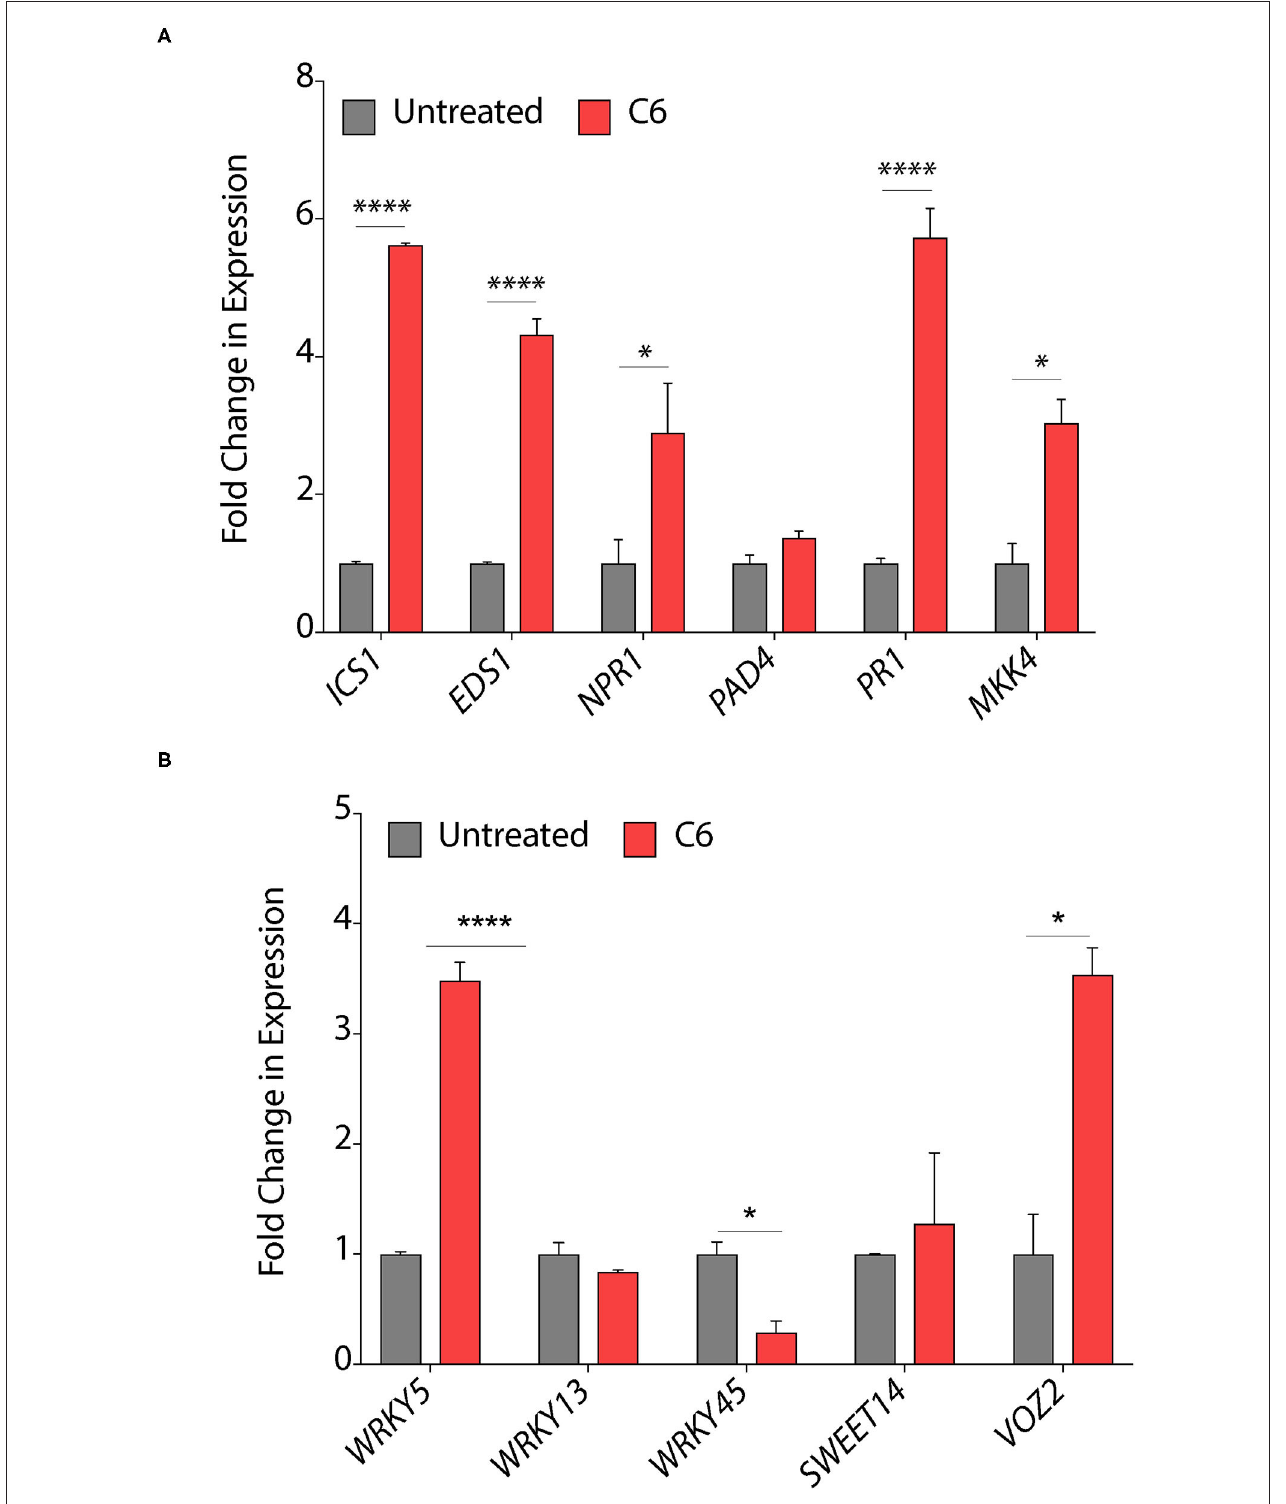
FIGURE 5 | Response of plant defense genes upon CAGCs treatment. (A, B) Change in expression of plant immunity associated genes in response to Xoo and C6 treatment. The expression of SA signaling and pathogen related genes were performed from leaf samples infected with Xoo followed by C6 treatment after 48 hps. Minimum three biological replicates were used for each time point and experiments were repeated three times with similar data. Statistical significance was performed with two-way ANOVA ( α = 0.05, * p < 0.05, **** p < 0.0001).